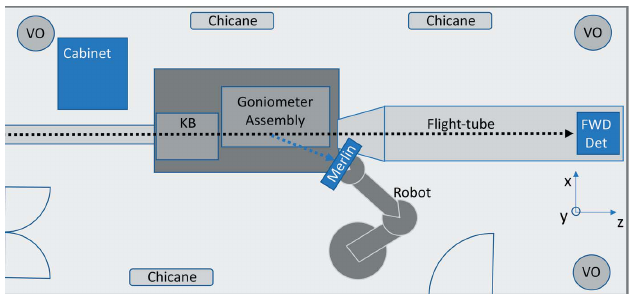
Figure 2 Layout of the experimental hutch hosting the diffraction endstation at NanoMAX. The directions of the forward and diffracted X-ray beams are marked by dashed lines. The ventilation outlets (VO), the inside electronic cabinet, the chicanes used for the cables, the focusing mirrors (KB), the goniometer assembly, the robot detector holding the Merlin detector, the 2D forward detector (FWD Det) and the flight tube are